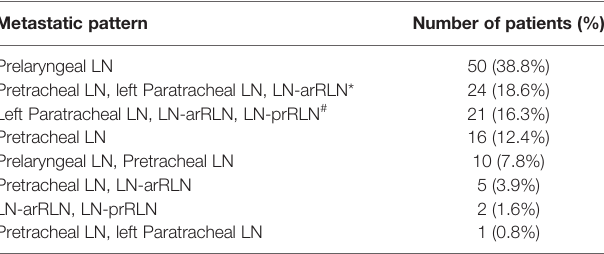
TABLE 1 | Pattern of the central lymph node (LN) metastasis in the 129 patients. Metastatic pattern Number of patients (%) Prelaryngeal LN